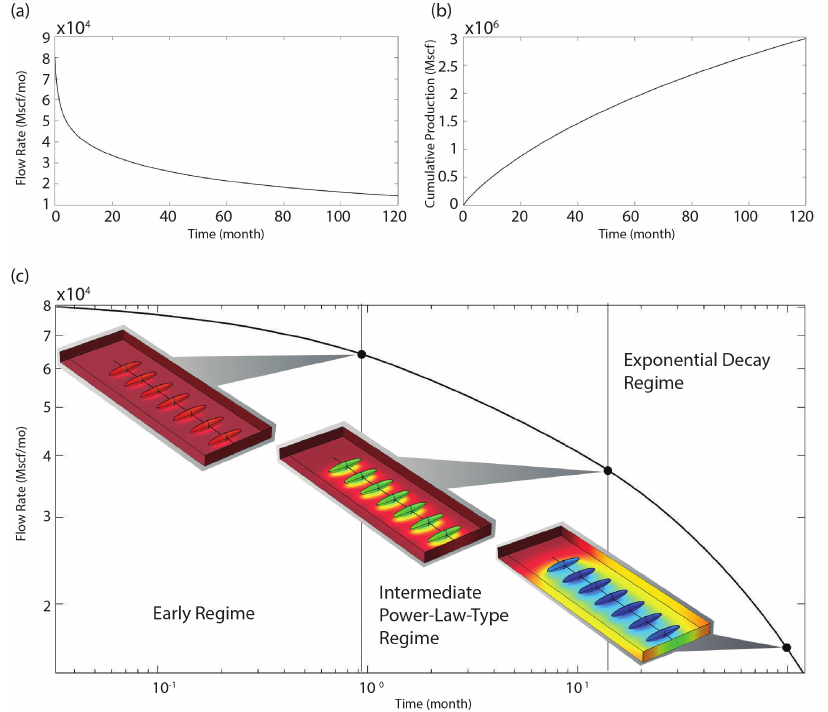
Figure 4. Gas production graph. Flow rate ( a ) and cumulative production ( b ) of methane in linear scale. ( c ) Flow rate of methane in log-log scale. Ten year